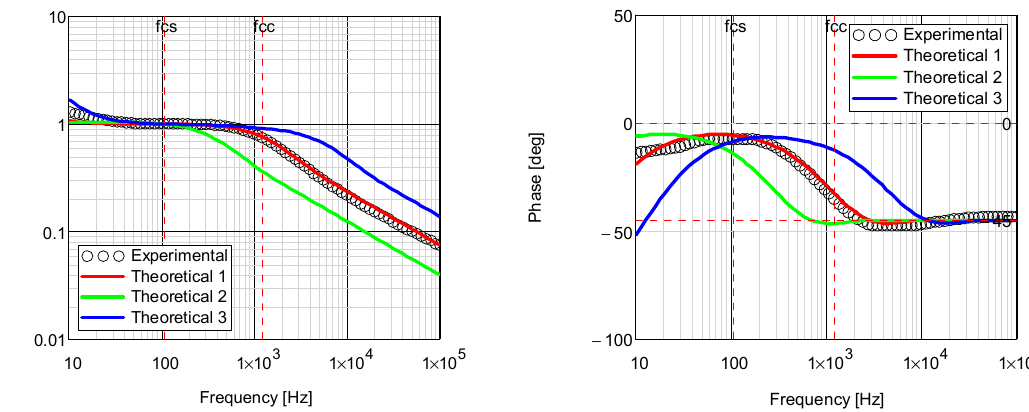
Figure 12. Theoretical and experimental PTR amplitude and phase characteristics obtained for the TMZ-II sample. The solid red line (Theoretical 1) was calculated for the best fit values of thermal parameters ( α c = 2.342 ± 0.060 cm 2 /s, λ c = 2.523 ± 0.117 W/cm · K). The solid green line (Theoretical 2) was calculated for the best fit values of thermal parameters divided by 4 ( α /4, λ /4). The solid blue line (Theoretical 3) was calculated for the best fit values of thermal parameters multiplied by 4 (4 × α , 4 × λ ). Circles are experimental data. The PTR experimental and theoretical amplitude and phase frequency characteristics of the TMZ-II + Ce(NO 3 ) 3 sample are presented in Figure 13.